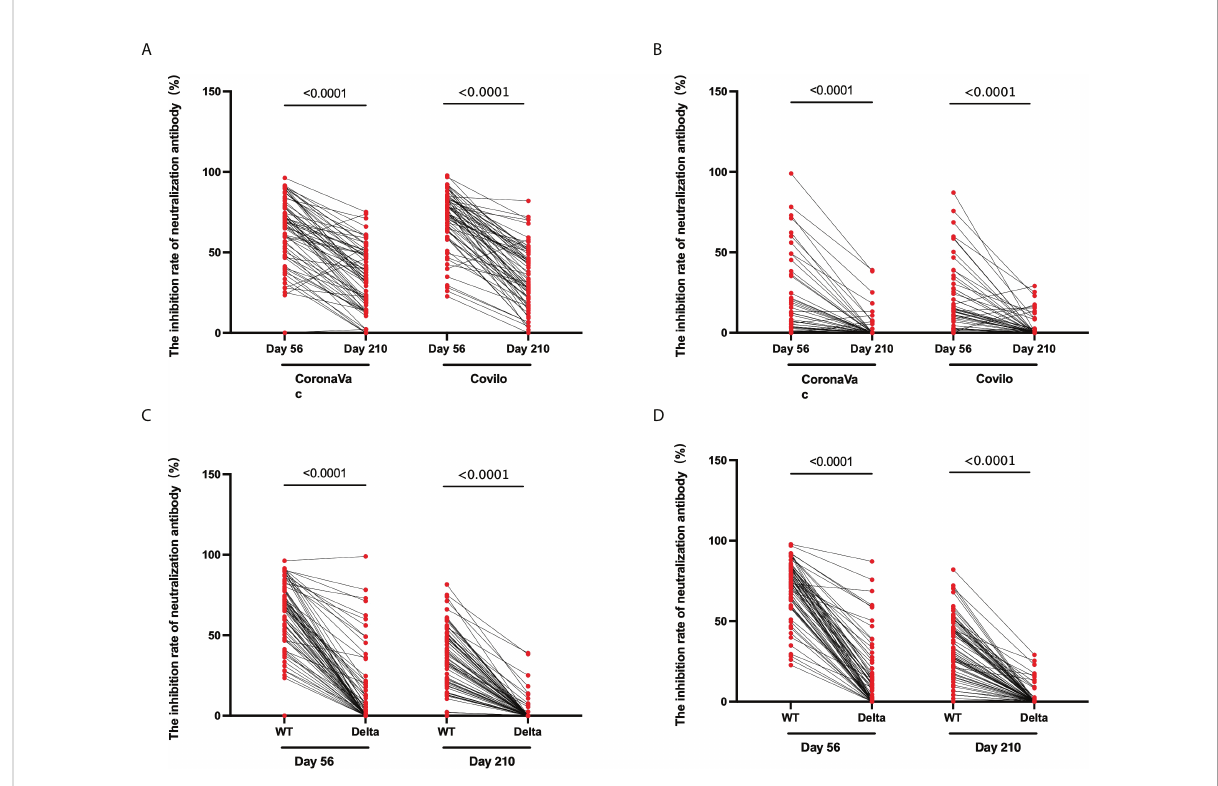
FIGURE 5 Dynamic changes in the inhibition rates of neutralizing antibody to pseudovirus. (A, B) Dynamic changes in infection inhibition rates of neutralizing antibody to pseudovirus against the WT of SARS-CoV-2 (A) or the Delta variant of SARS-CoV-2 (B) on Day 56 and Day 210 in samples from CoronaVac- and Covilo-vaccinated participants. (C, D) Comparison of inhibition rates against pseudovirus for the WT and the Delta variant of SARS-CoV-2 on Day 56 and Day 210 for CoronaVac-vaccinated (C) or Covilo-vaccinated (D)